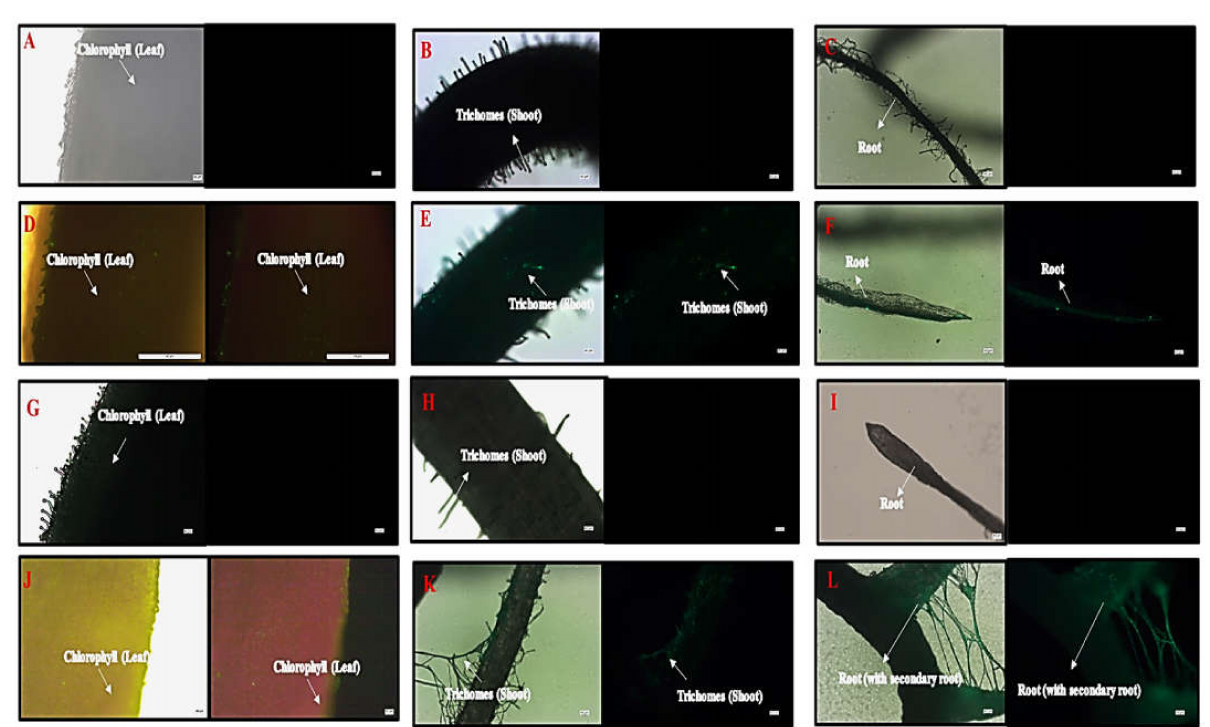
Figure 9. Microscopic images of control plant, (( A ). leaf, ( B ). shoot, ( C ). root), Flu − PS-interacted plant (( D ). leaf (with light, and under fluorescence light), ( E ). shoot (with light, and under fluorescence light), ( F ). root (with light, and under fluorescence light)), HA-interacted plant (( G ). leaf, ( H ). shoot, ( I ). root) and Flu − PS+HA-interacted plant (( J ). leaf (with light, and under fluorescence light), ( K ). shoot (with light, and under fluorescence light), ( L ). root (with light, and under fluorescence